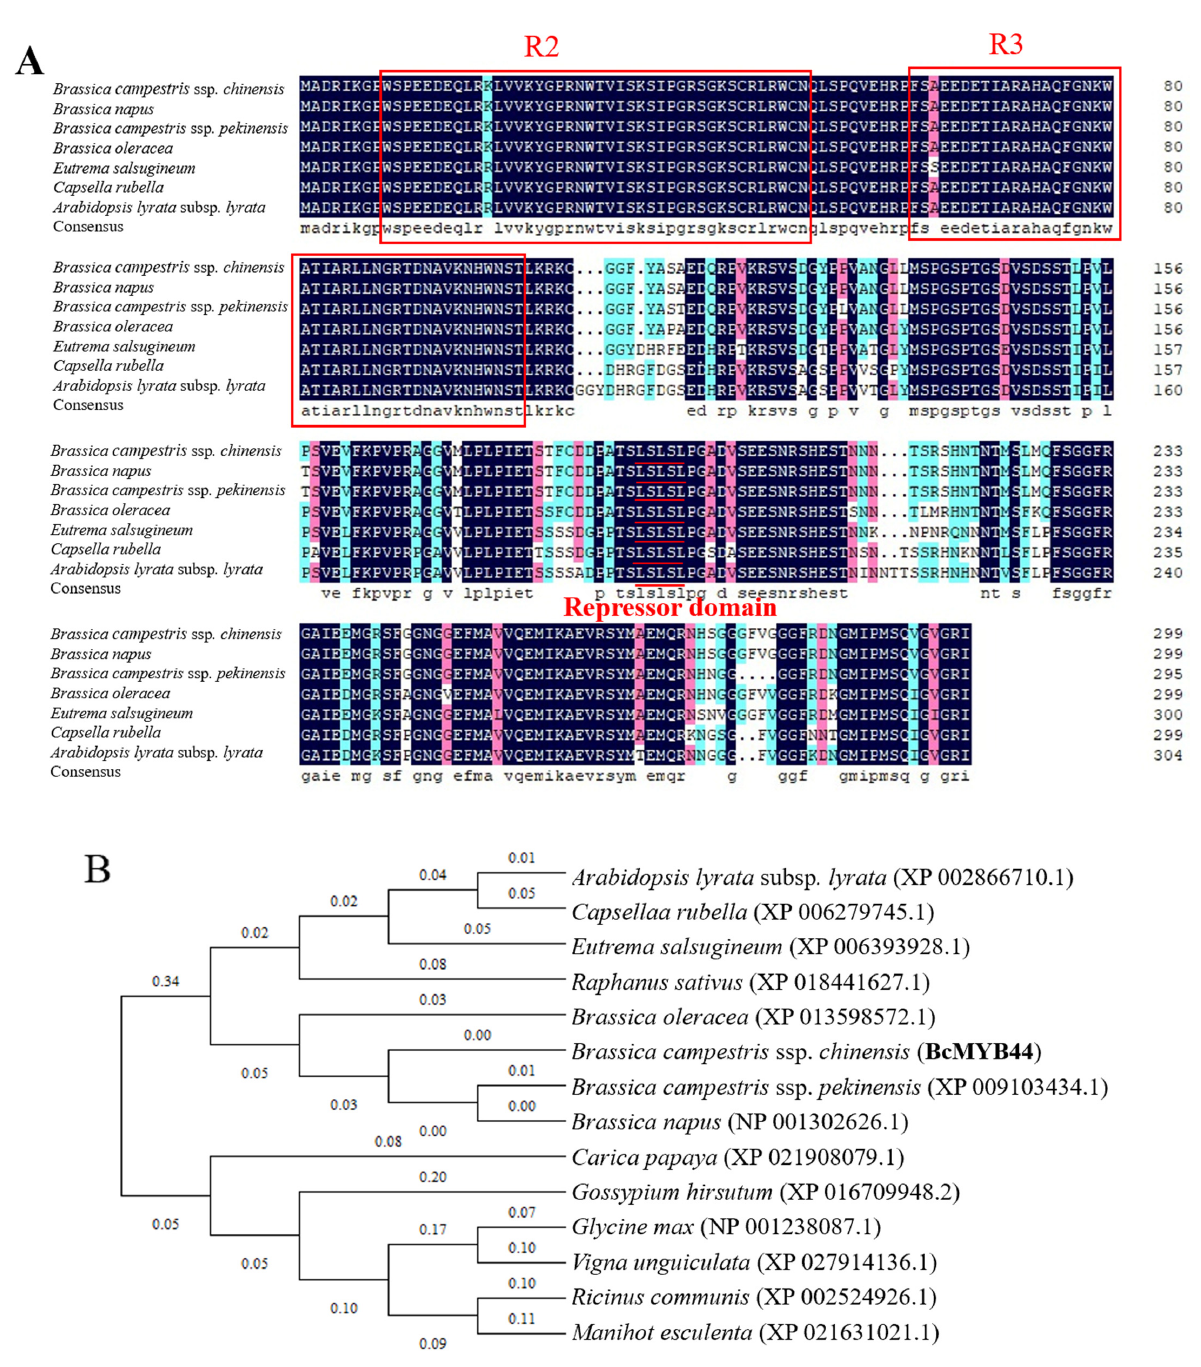
Figure 1. Sequence Analysis of BcMYB44. ( A ) The multiple sequence alignment of BcMYB44 protein with MYB44-like proteins in Brassica compestris ssp . chinensis .; Brassica napus .; Brassica compestris ssp . pekinensis .; Brassica oleracea .; Eutrema salsugineum .; Capsela rubella .; Arabidopsis lyrata subsp . lyrata .R2, R3: DNA-binding domains of MYB. ( B ) Phylogenetic analysis of BcMYB44 protein and MYB TFs proteins in other species ( Arabidopsis lyrata subsp . lyrata ; Capsella rubella .; Eutrema salsuqineum .; Raphanus sativus .; Brassica oleracea .; Brassica compestris ssp. pekinensis .; Brassica napus ., Carica papaya .; Gossypium hirsutum .; Glycine max .; Vigna unguiculata .; Ricinus communis .; Manihot esculenta .).